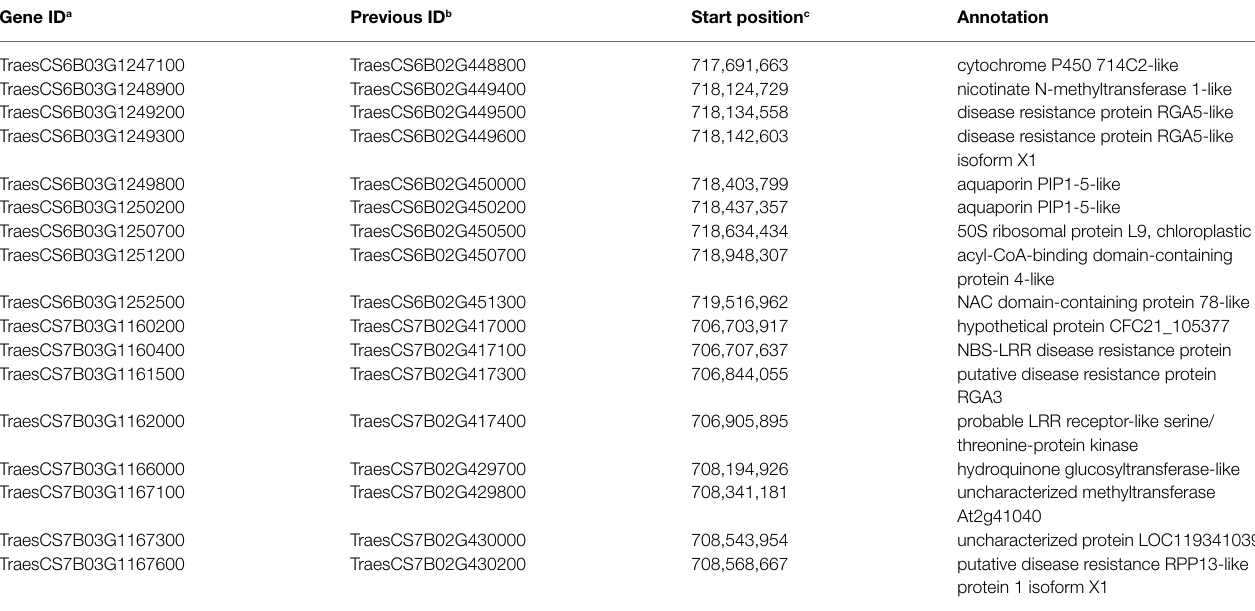
TABLE 3 | Candidate genes identified for two QTLs for FDK, S6B_718194425 and S7B_707550430 , with putative functions of interest and their functional annotation. Gene ID a Previous ID b Start position c